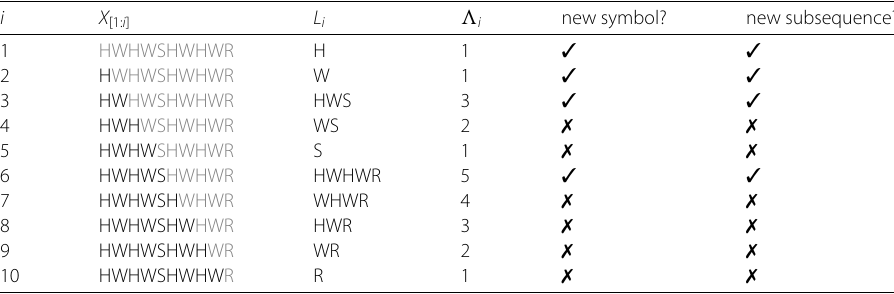
Table 1 An example illustrating the innerworkings of Equation 1 on an input sequence X = ( H , W , H , W , S , H , W , H , W , R ). The notation X [1: i ] denotes the symbols in X from 1 to i – 1, L i denotes the shortest subsequences that starts at position i and does not appear from 1 to i – 1 in the original sequence, and (cid:2) i is given by | L i | . We note that every time a new (previously unseen)